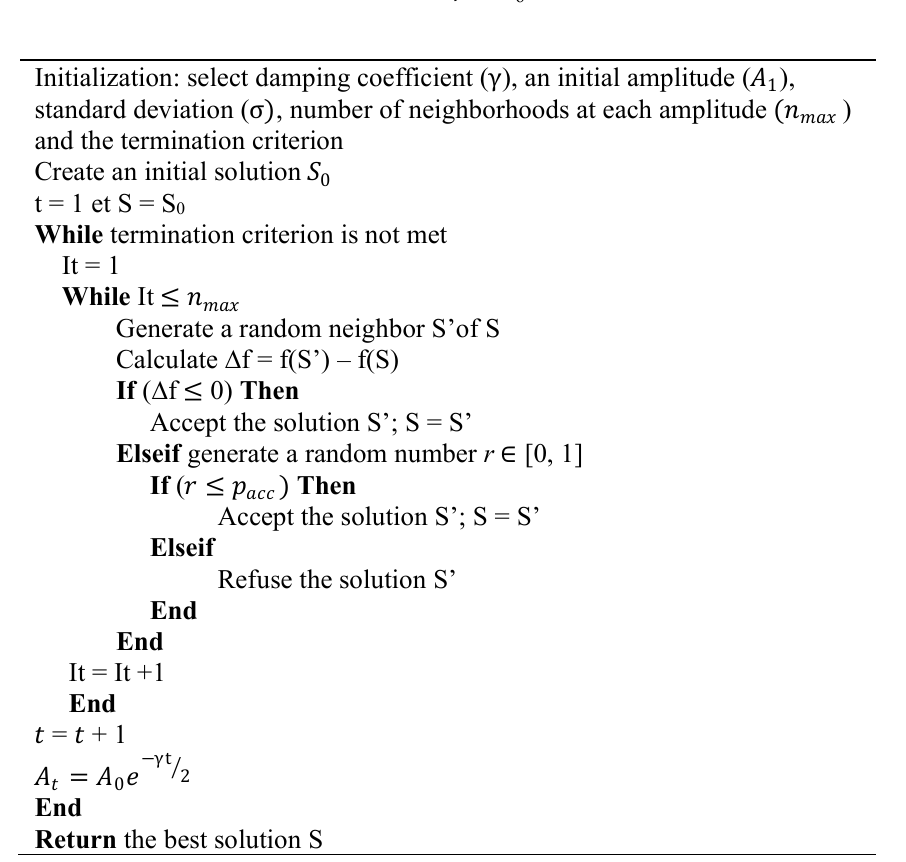
Figure 8. Pseudocode of the used vibration damping optimization algorithm.